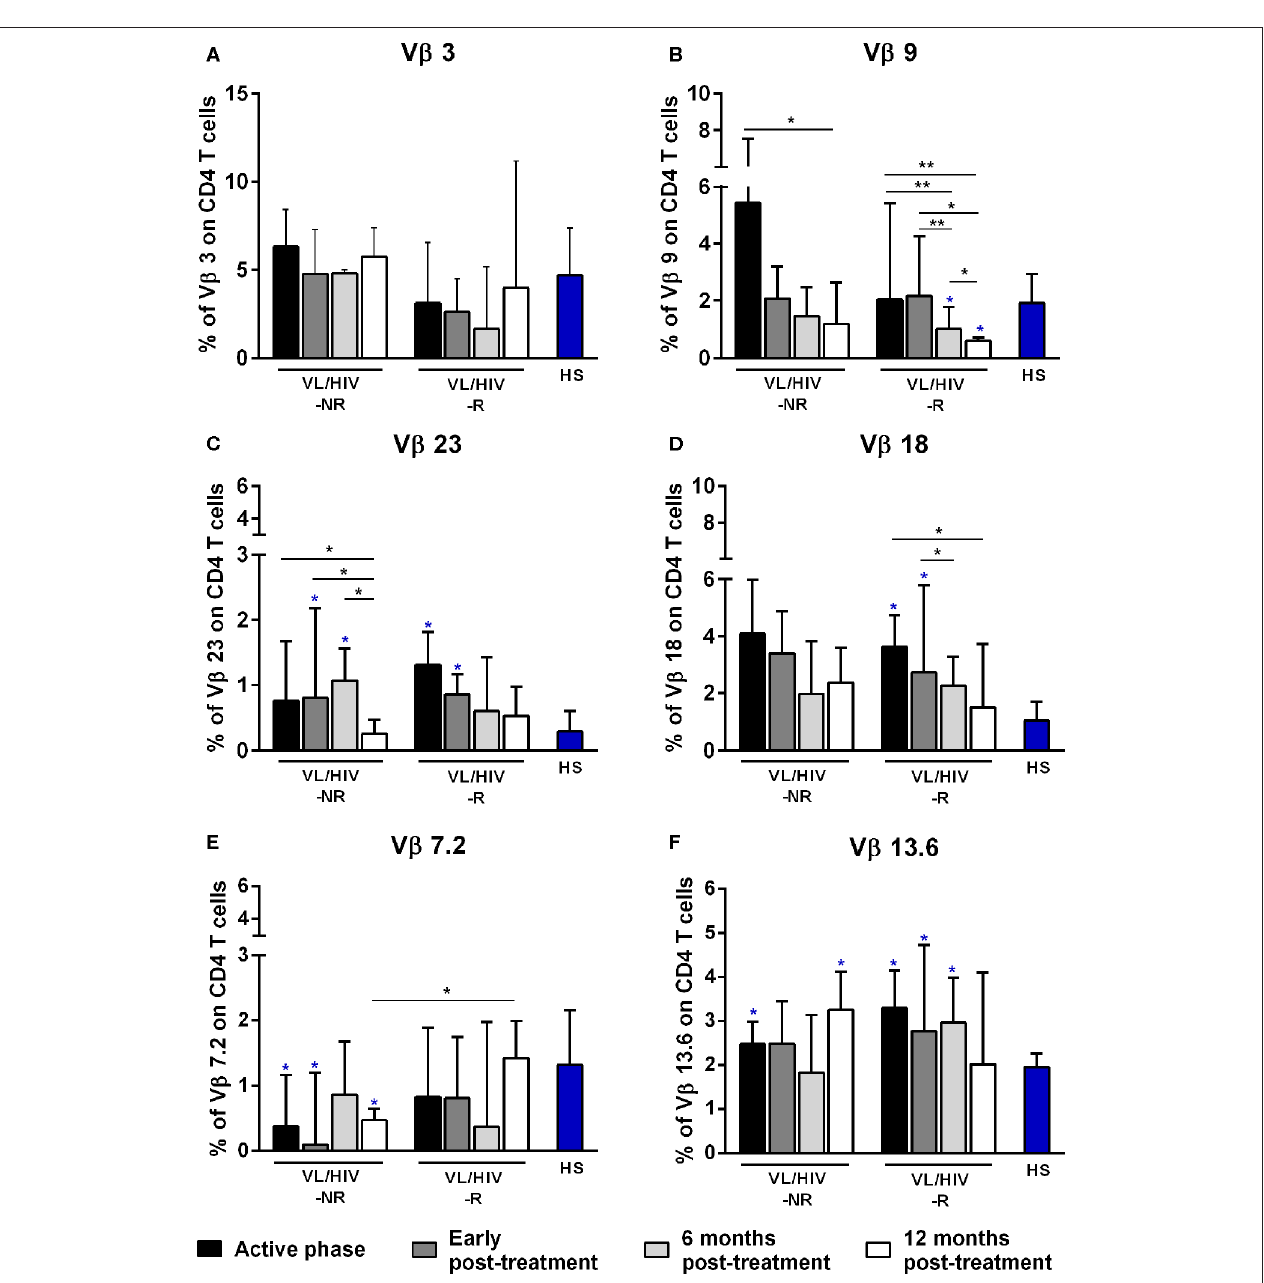
FIGURE 1 | Percentages of the V β families on CD4 + T lymphocytes among non-relapsing (NR) and relapsing (R) visceral leishmaniasis/HIV (VL/HIV) co-infected patients. The mobilization percentages of V β 3 (A) , V β 9 (B) , V β 23 (C) , V β 18 (D) , V β 7.2 (E) , and V β 13.6 (F) in NR-VL/HIV co-infected patients in comparison to R-VL/HIV group. The blue asterisk represents the statistical differences in relation to healthy subjects (HS). The column bar represents the median values with interquartile range. * p < 0.05 ** p < 0.005.